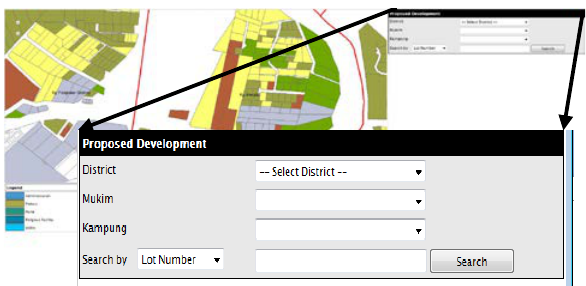
Figure 3: e-DIA search tool